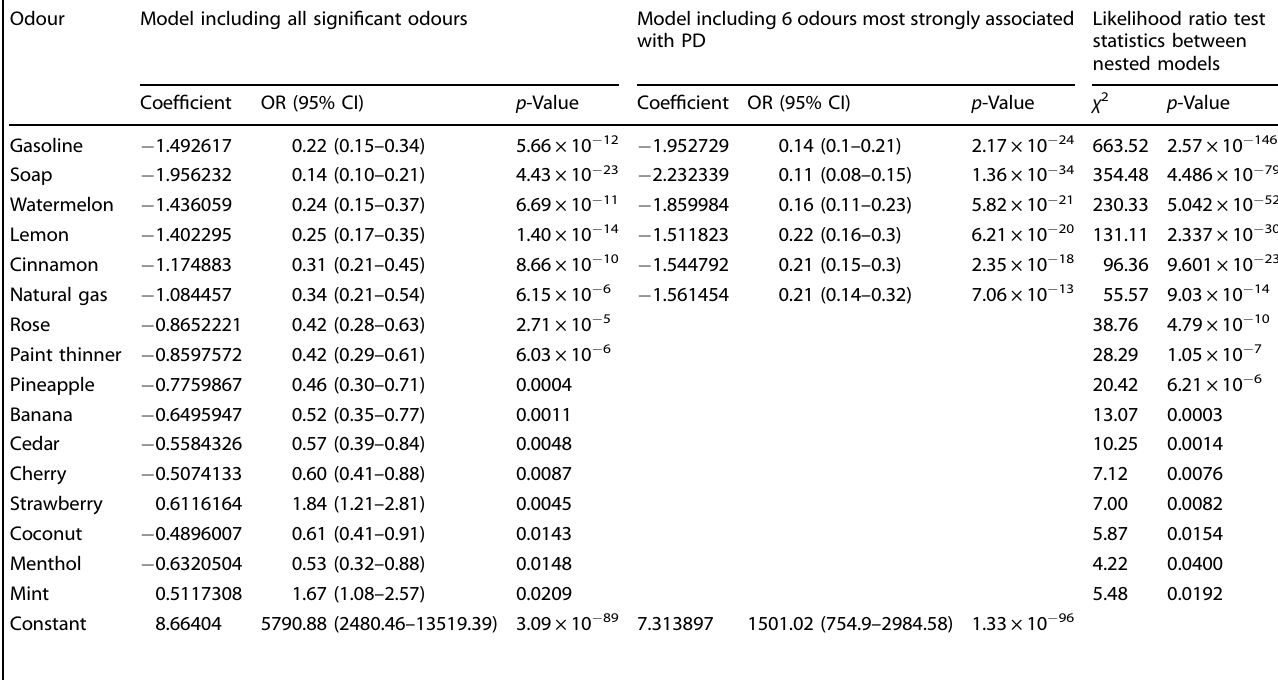
Table 1. Results of multivariate logistic regression analyses of the odours common to the UK and US versions of the UPSIT, and the 6 odours most strongly associated with Parkinson ’ s disease.